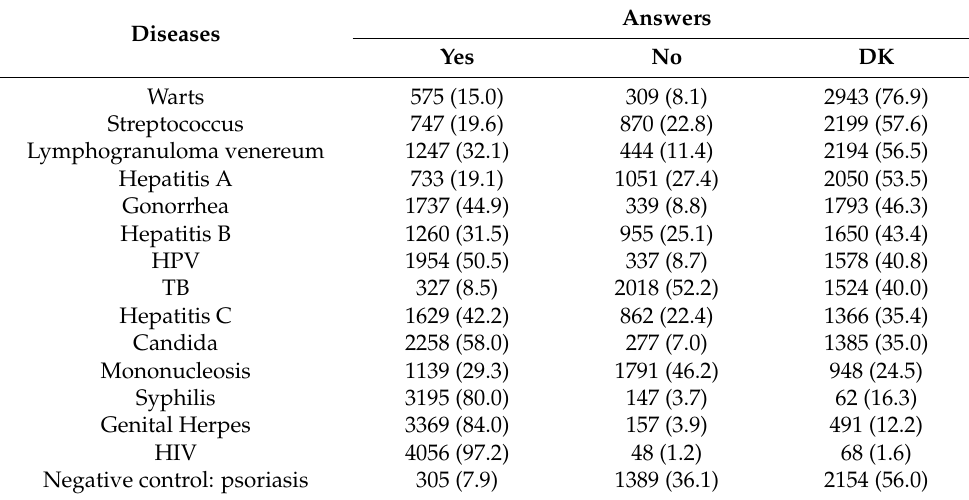
Table 2. Answers to the question: “Which of the following diseases can be transmitted by sex?” Number and row percentage (%). DK = I do not